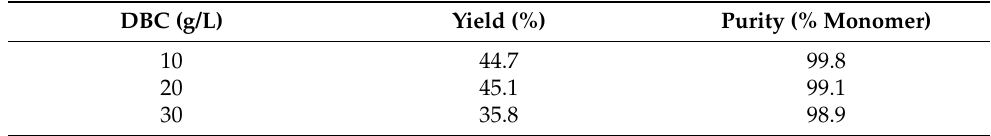
Table 1. Yield and purity (% monomer) results according to DBC